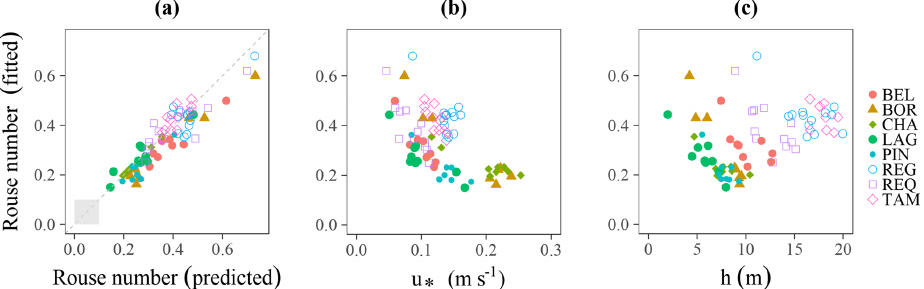
Figure 9. Fitted Rouse numbers against (a) predicted P s (the gray square in the bottom-left represents the range of variation of P f ), (b) shear velocities and (c) water